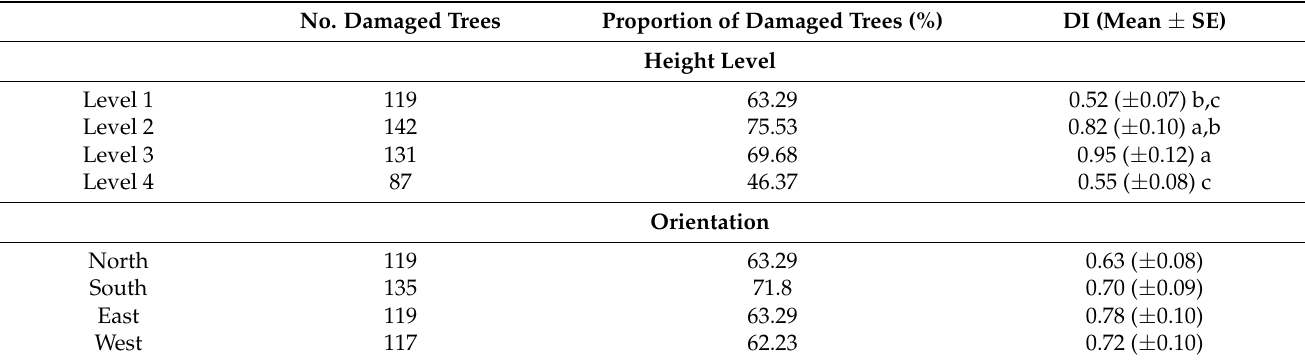
Table 6. Number of damaged trees by C. undatus and their proportion according to the four damaged height levels and the four orientations separately. DI = Tree Damage Intensity. SE = standard error of means. Small cases letter showed significant differences according to the post hoc tests.